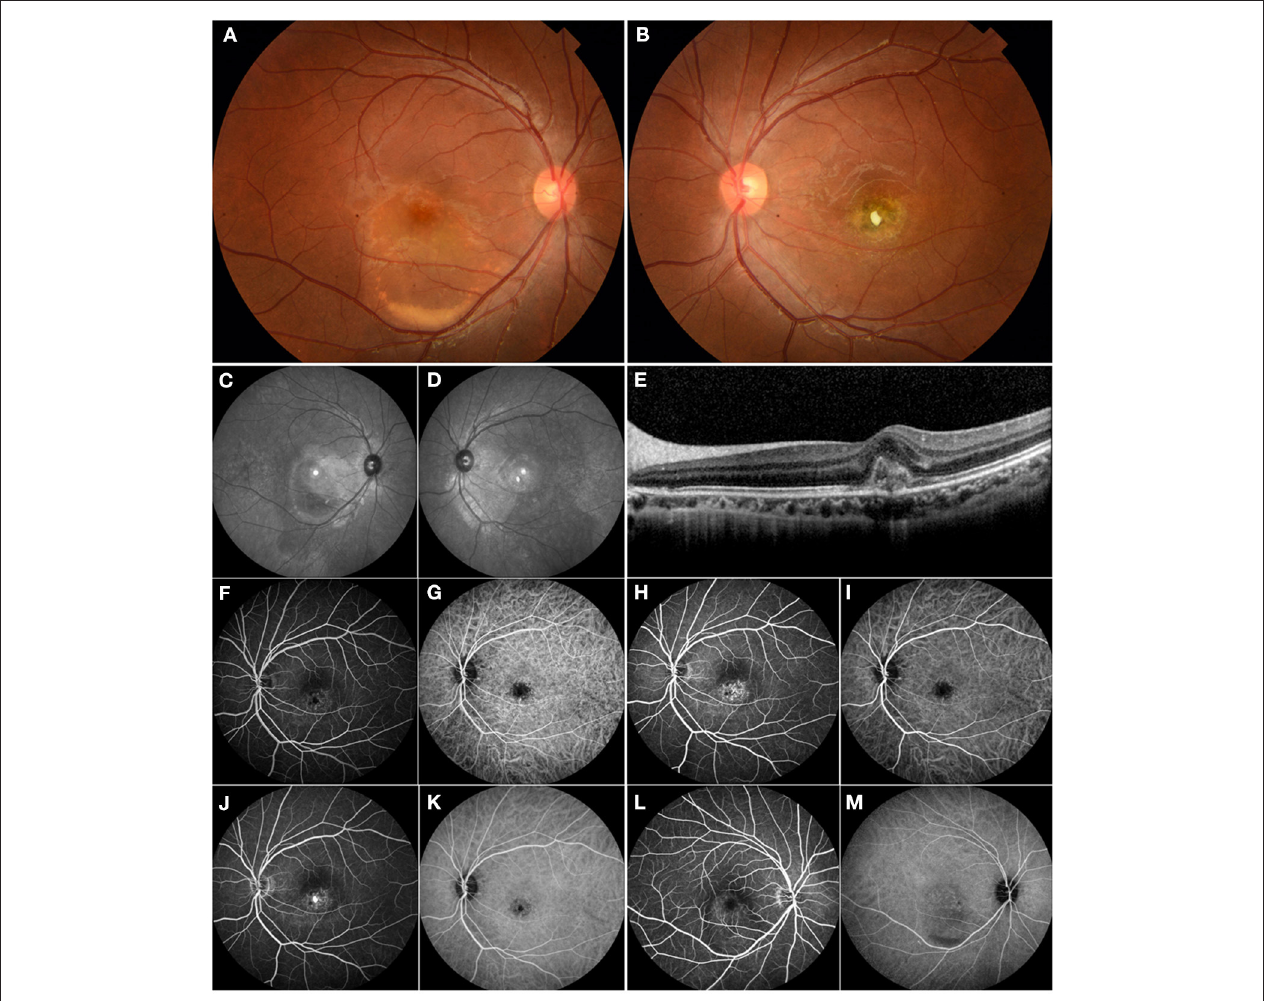
FIGURE 1 | Multimodal imaging of a 17-year-old male who presented with choroidal neovascularization (CNV) related to Best vitelliform macular dystrophy. His family history was unremarkable. His BCVA was 0.1 logMAR in the right eye and 1.1 logMAR in the left eye. (A) Fundus examination of the right eye revealed a color photo: a vitelliform lesion in the submacular area indicating Best disease. (B) The left eye showed a yellow-white fibrotic membrane—an area of atrophy and pigmentation. (C,D) The red-free images showed macular hyperautofluorescence in both eyes. (E) OCT revealed the typical subfoveal hyperreflective at the level of the RPE. (F,H,J) FFA demonstrated mild hyperfluorescence in the macular area and frank hyperfluorescence in the late phase consistent with subfoveal CNV in the left eye. (G,I,K) ICGA showed hypofluorescence in the macular area consistent with the lesion. (L) FFA demonstrated mild hyperfluorescence in the macular area secondary to a vitelliform lesion in the right eye. (M) ICGA showed mild hypofluorescence secondary to a vitelliform lesion in the right eye. The patient underwent intravitreal ranibizumab treatment for his left eye. However, he did not notice any significant visual